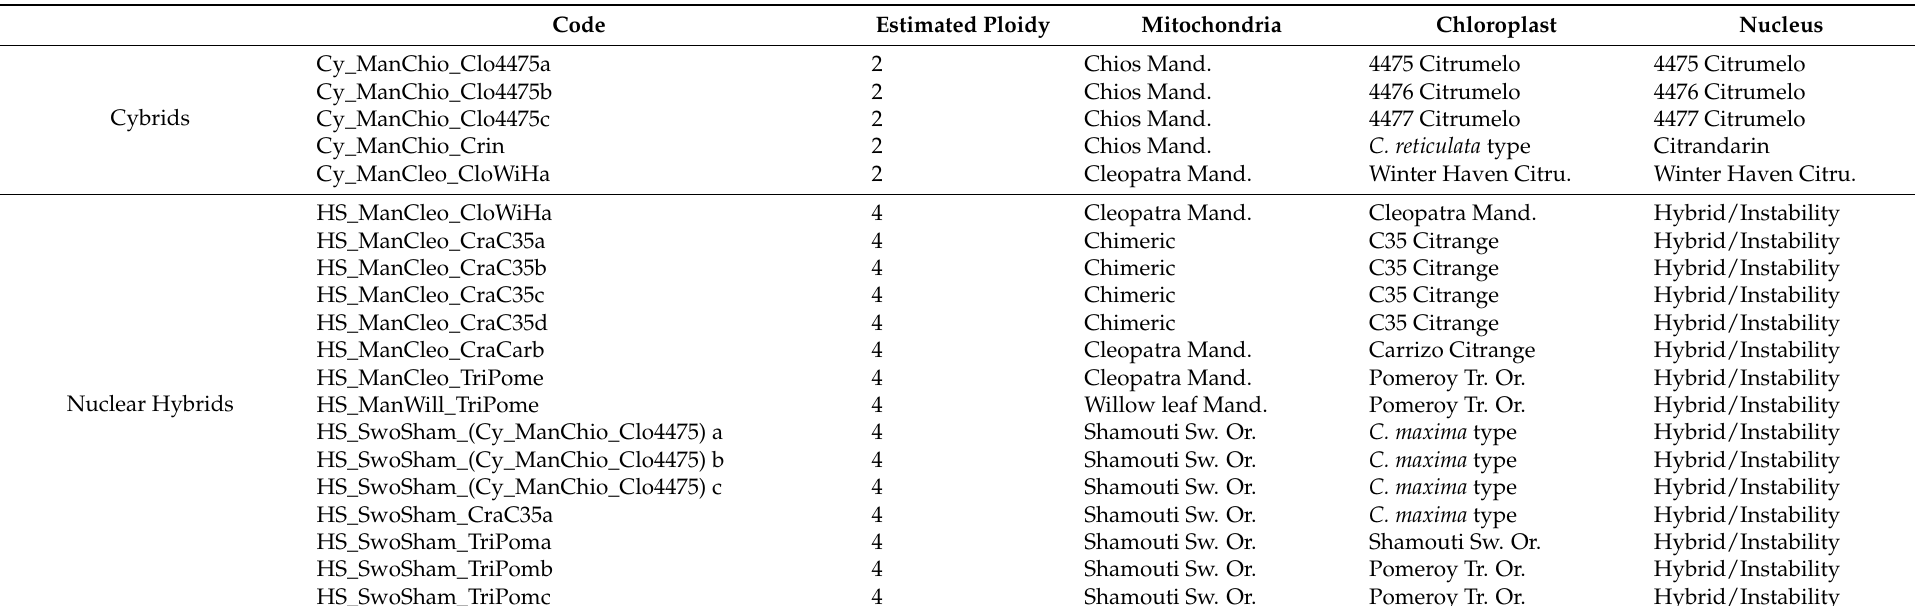
Table 3. Synthesis of genome characterization for cybrids and nuclear somatic